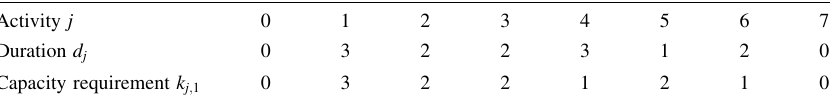
Table 1 Activity durations and capacity